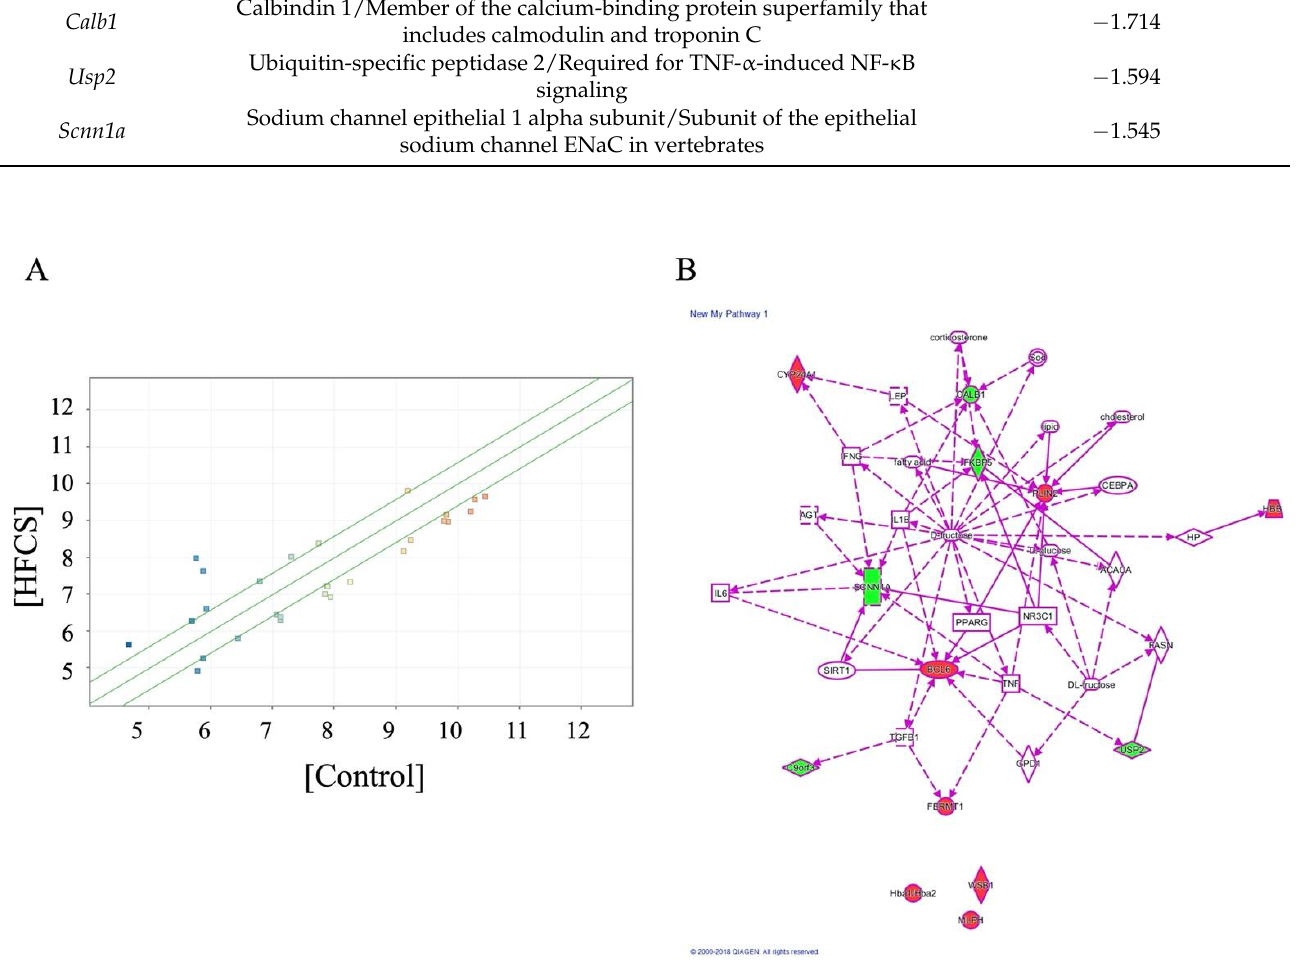
Figure 4. mRNA expression of Cyp24a , Plin2 , Usp2 , and Calb1 genes in Wistar rat kidneys from the high-fructose corn syrup (HFCS) and control groups. Expression levels of the target genes were normalized to those of β-actin ( n = 10 per group). * p < 0.05 HFCS versus control group (Mann-Whitney U -test). RQ, relative quantification by real-time polymerase chain reaction.